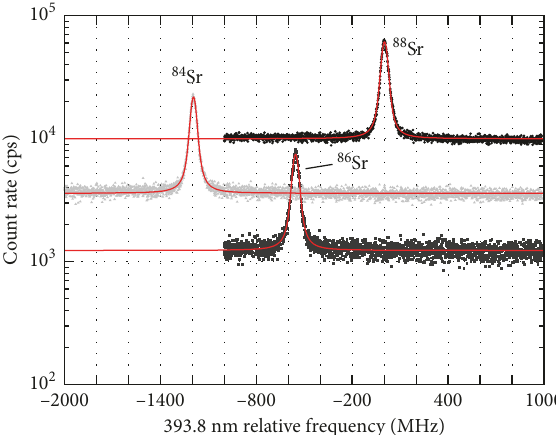
Figure 4: Isotope shift of strontium for the 393.8nm